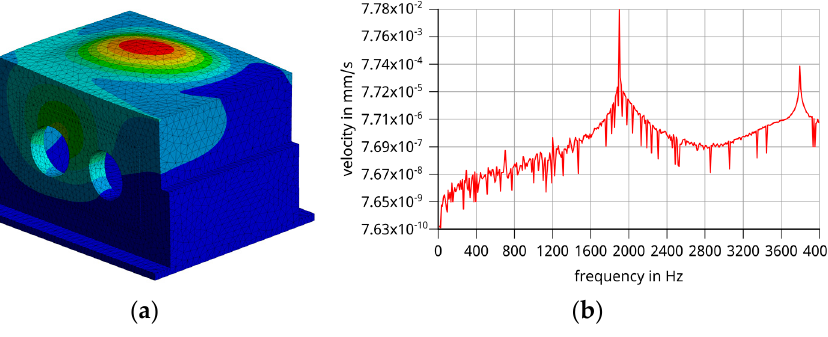
Figure 7. FEA project schematic.